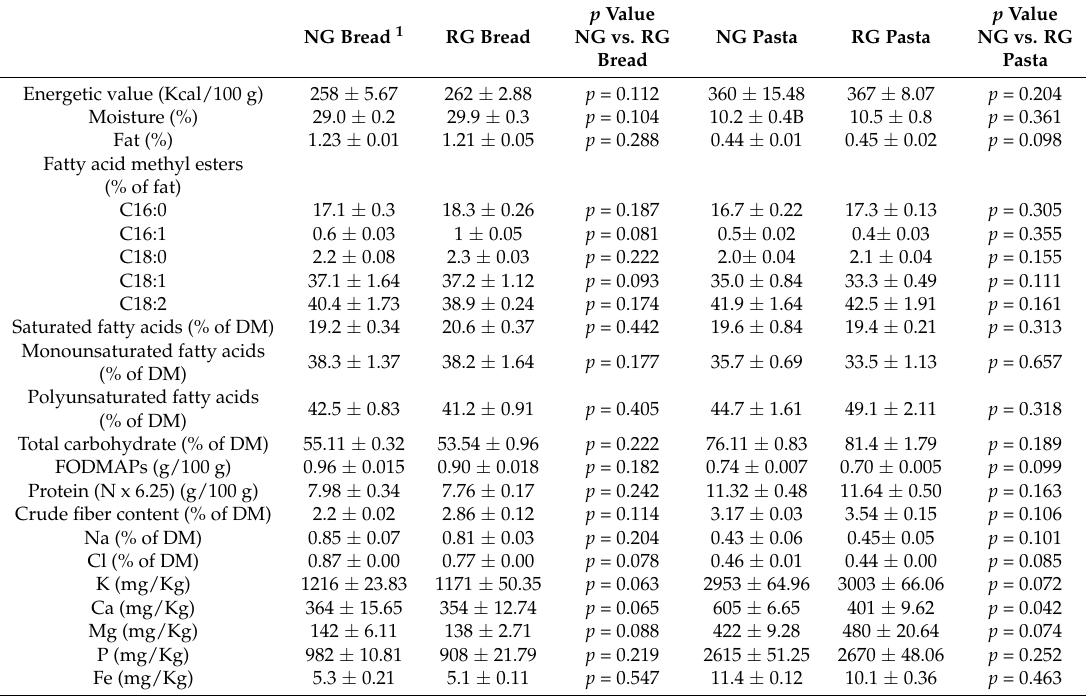
Table 1. Chemical composition and nutritional indexes of bread and pasta made with normal-(NG) and reduced-(RG) gluten content flours. RG wheat flour was fermented with fungal proteases and selected lactobacilli at 30 ◦ C for 8 h. p Value p Value NG vs. RG NG Pasta RG Pasta NG vs. RG NG Bread 1 RG Bread Bread Pasta Energetic value (Kcal/100